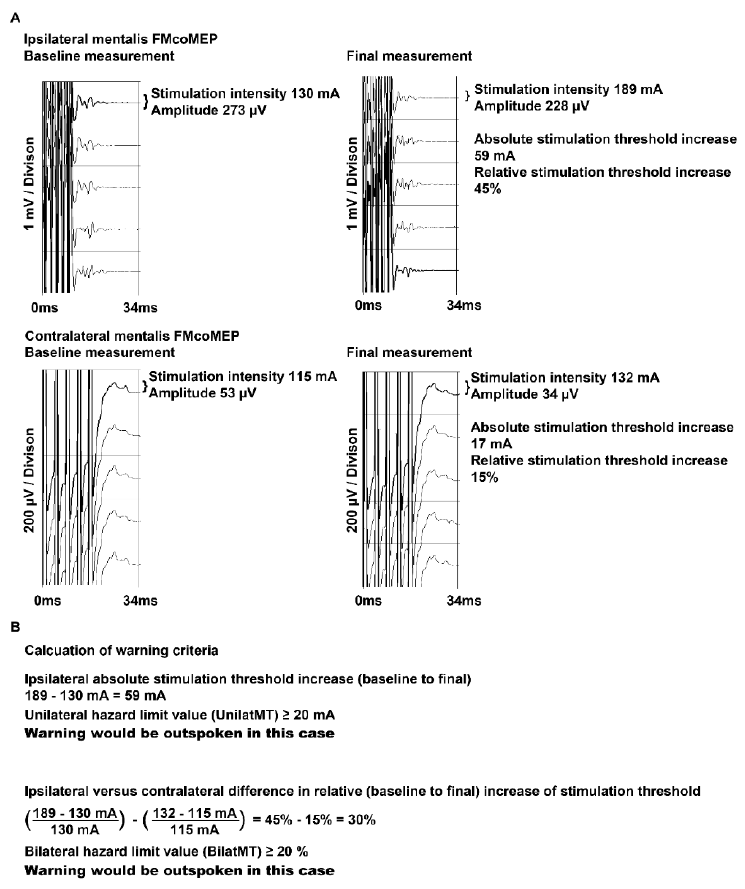
Figure 3. Exemplary IOM data and calculation of warning criteria of patient 11. ( A ) Baseline and final FMcoMEP measurements of the mentalis muscle on the ipsilateral and contralateral sides are shown. For each potential, the amplitude and stimulation intensity are measured. ( B ) Exemplary calculation. The upper calculation refers to the UnilatMT criterion and is calculated by subtracting the baseline from the final stimulation threshold. In this case, the UnilatMT criterion is met because the ipsilateral versus contralateral difference is 59 mA, which is above the 20 mA hazard limit. The bottom calculation refers to the BilatMT criterion and is calculated by subtracting the relative ipsilateral from the relative contralateral increase. In this case, the BilatMT criterion is met because the relative difference is 30%, which is above the 20% hazard limit. Table 4. Risk